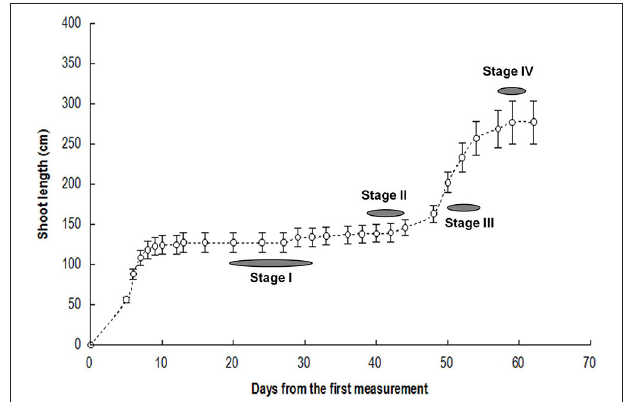
FIGURE 1 | Flush growth and stages for bud sampling. Vertical bars represent standard errors of means ( n = 3).